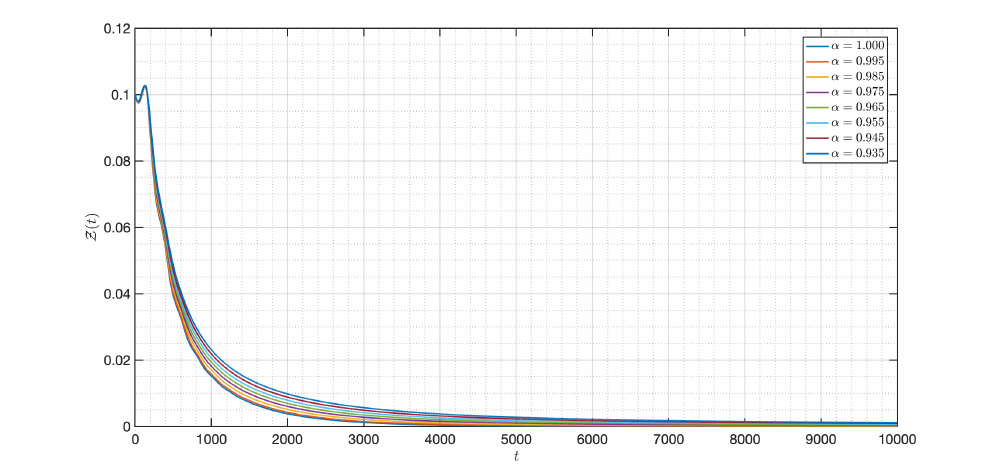
Figure 37. Dynamic of I ( t ) of the model (3) for different parameters in Case IV .